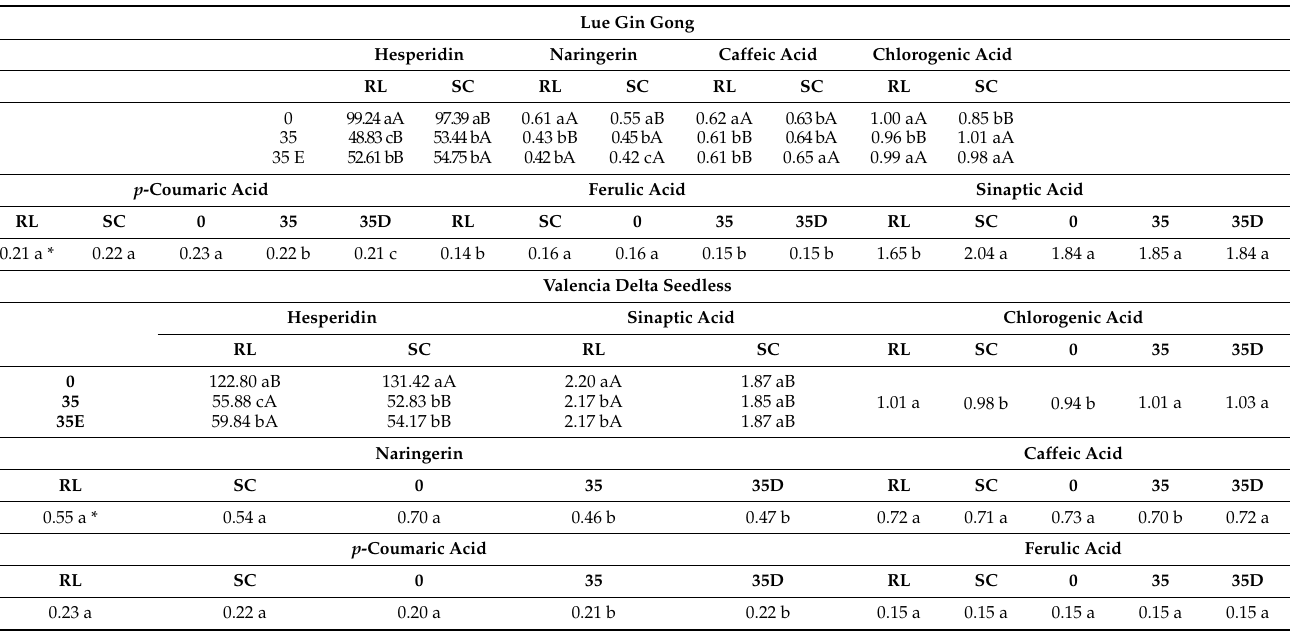
Table 5. Concentration of phenolic compounds (mg/L) in ‘Lue Gin Gong’ and ‘Valencia Delta Seedless’ juices with different combinations of rootstock submitted to 35 days of